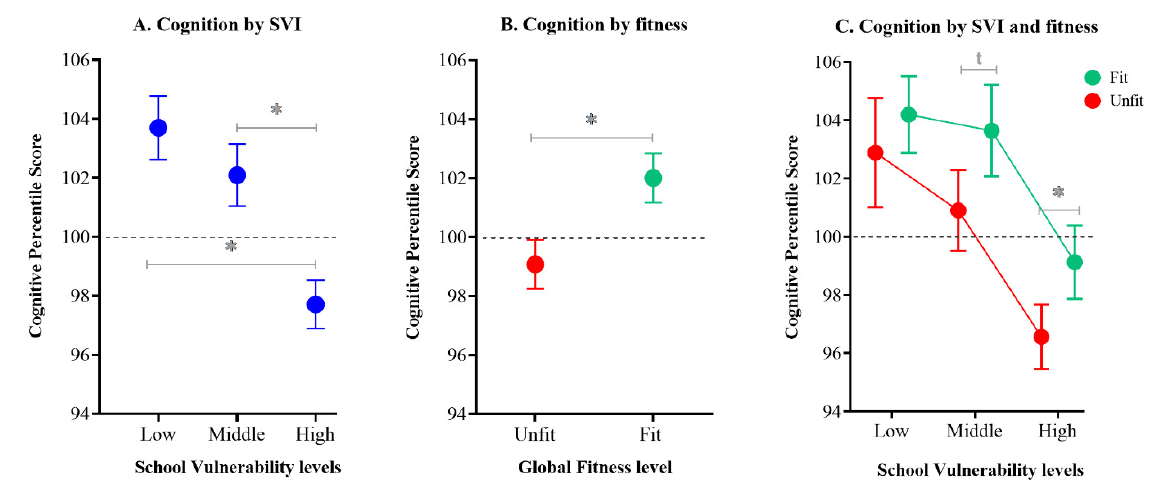
Figure 1. Cognitive performance according to school vulnerability and global fitness levels. ( A ) Cognitive performance according to school vulnerability index levels; ( B ) Cognitive performance according to level of global fitness; ( C ) Cognitive performance according to level of global fitness and school vulnerability index levels. Estimated mean marginal and 95% CI. Normal distribution of the cognitive percentile score with a mean of 100. * indicate p < 0.05; t indicates a trend (Cohen’s d > 0.2 and p > 0.05).